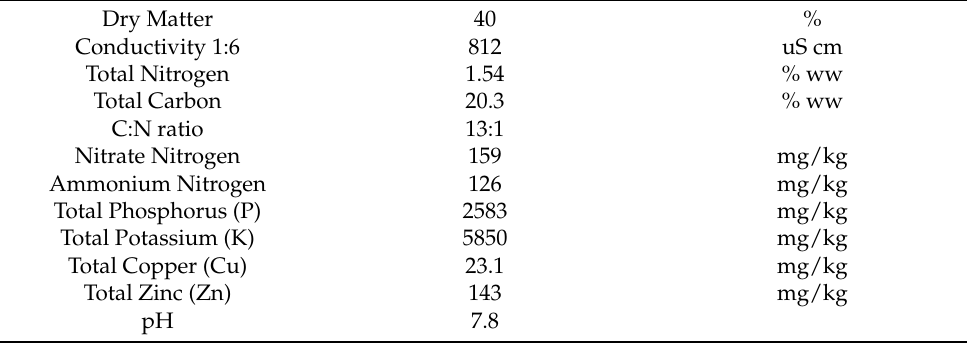
Table 2. Composition of composted greenwaste (analytical results are expressed on a dry matter